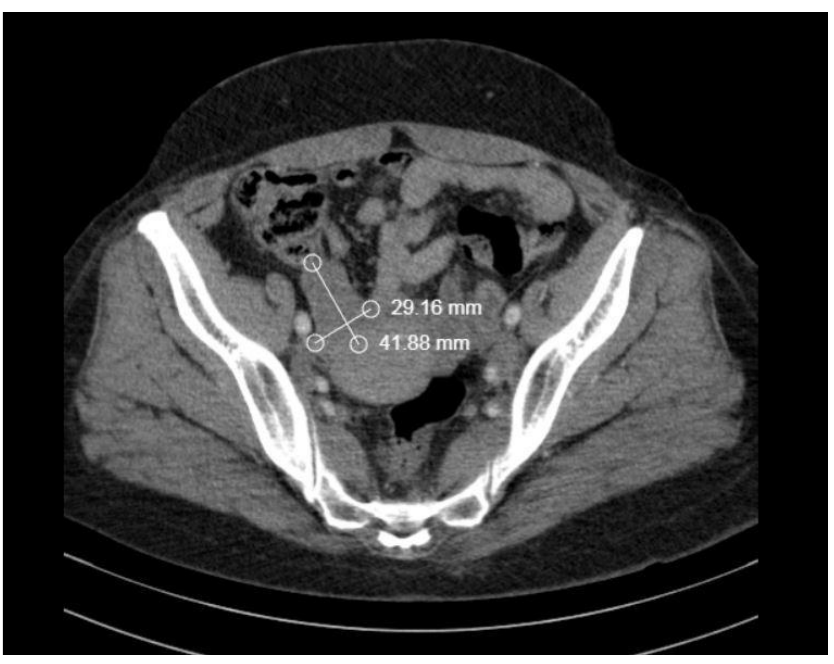
Figure 6. The restaging CT of the right ovary: sizes were reduced more than 50%.